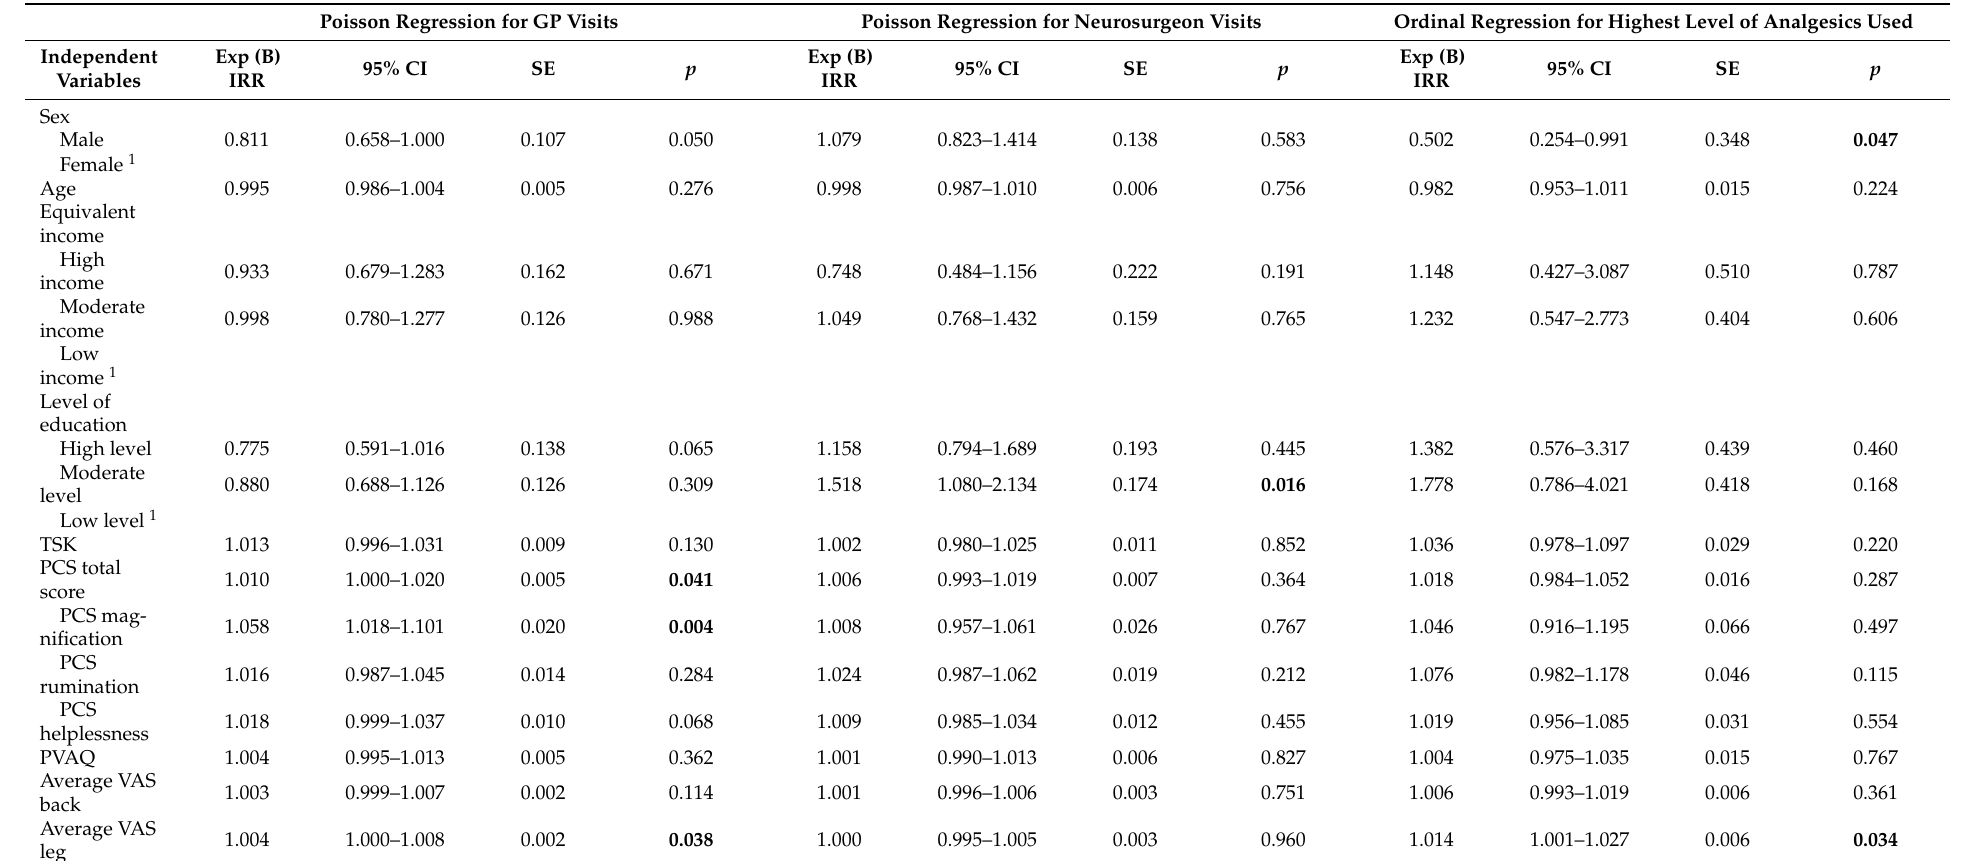
Table 2. Univariable analyses for associations between HCU (number of GP and neurosurgeon visits and highest level of analgesics used) and demographics, pain intensity and